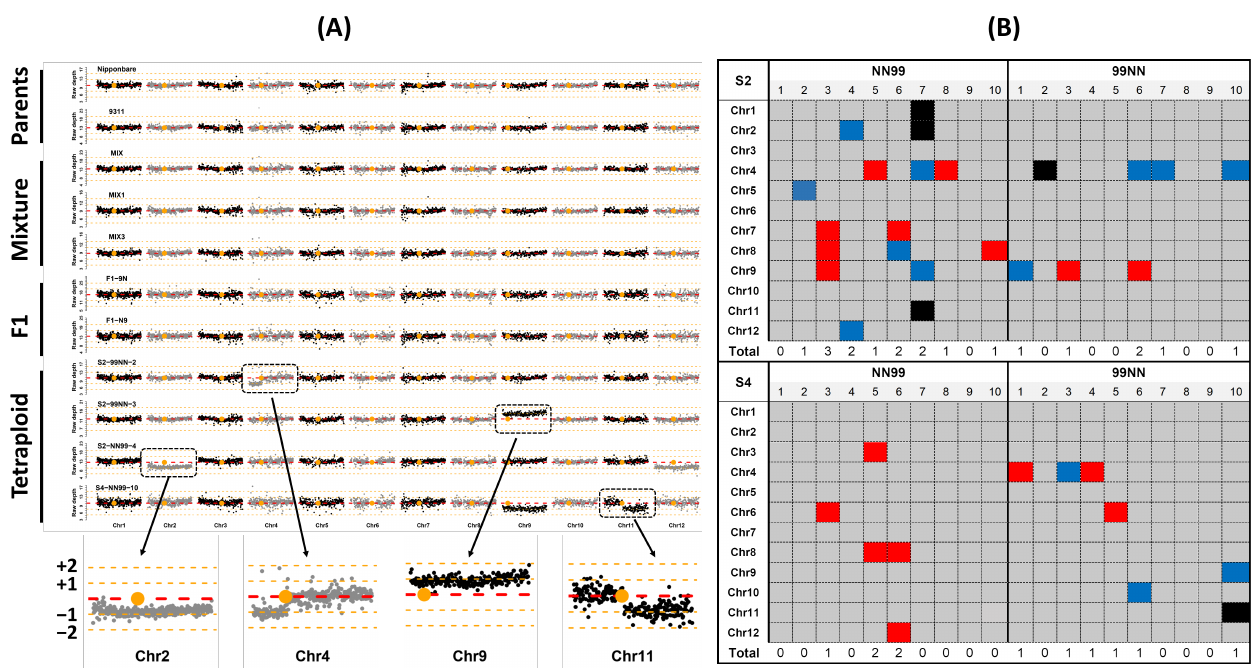
Figure 1. Representative karyotypes inferred from sequencing data and heatmap summary of aneuploidy in rice tetraploid S2 and S4 individuals. ( A ) Representative karyotypes. The genome- wide average sequencing depth is indicated by red dashed lines. The large orange dots represent centromeres. Each small black or grey dot represents a 1Mb window, and these two colors were used for distinguishing adjacent chromosomes. The x -axis shows the physical position of the window, and the y -axis shows the mean sequencing depth of the window. The four highlighted regions are four typical aneuploid chromosomes detected from four different tetraploid plants. The orange dashed lines from top to bottom are 1.5, 1.25, 0.75, and 0.5 of genome-wide depth, indicating +2, +1, − 1, and − 2 chromosomes in tetraploid. MIX, mixture of equal amount of Nippobare and 9311 data; MIX1, mixture of 1 9311 data and 3 Nipponbare data; MIX3, mixture of 3 9311 data and 1 Nipponbare data. 4 4 4 4 Parents, their mixtures, and F1 individuals served as negative controls for aneuploidy identification. ( B ) Heatmap summary of aneuploidy. Every column stands for one individual and each row stands for a chromosome. Chromosome gain (red) and loss (blue) are shown in different colors. Large segmental gain and loss are shown in black